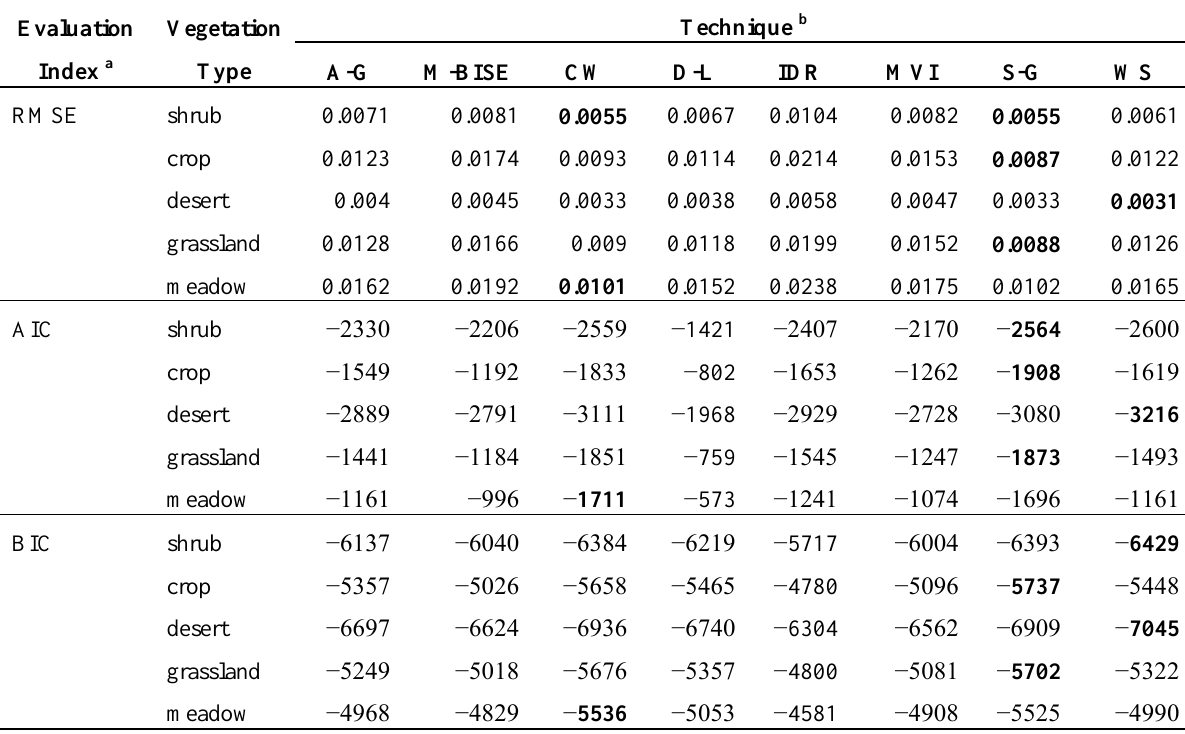
Table 3. RMSE, AIC, and BIC values for the eight techniques of Global Inventory Modeling and Map Studies (GIMMS) NDVI time-series data from January 1982 to December 2006 (best-fitting technique shown in